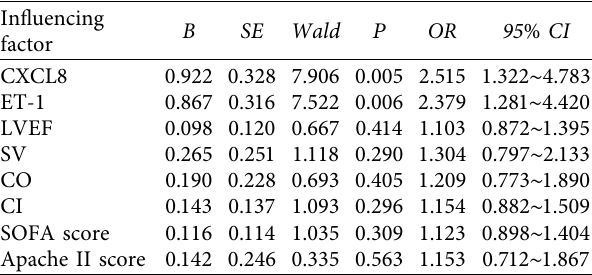
Table 5: Influencing factors of sepsis complicated with heart failure by logistic regression